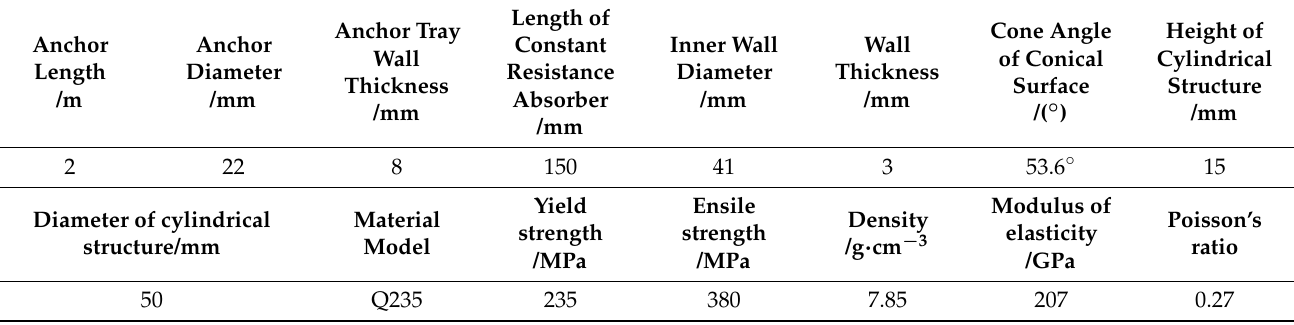
Table 2. The basic parameters of the energy absorbing anchor